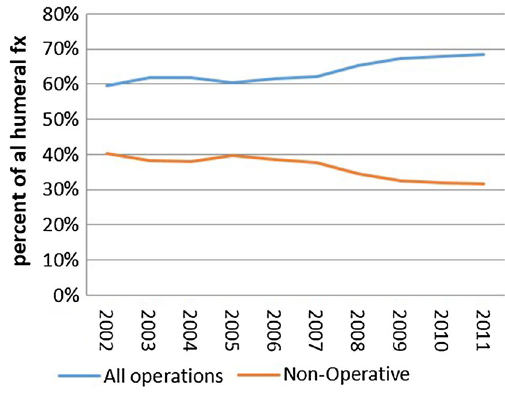
Fig. 2 Annual trend of operative and non-operative management of humeral shaft fractures